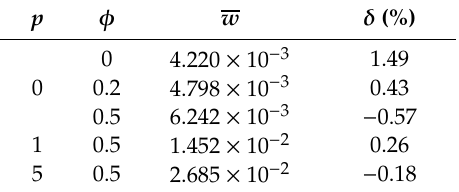
Table 2. Results of the porosity distribution model 1 (M1) verification study.